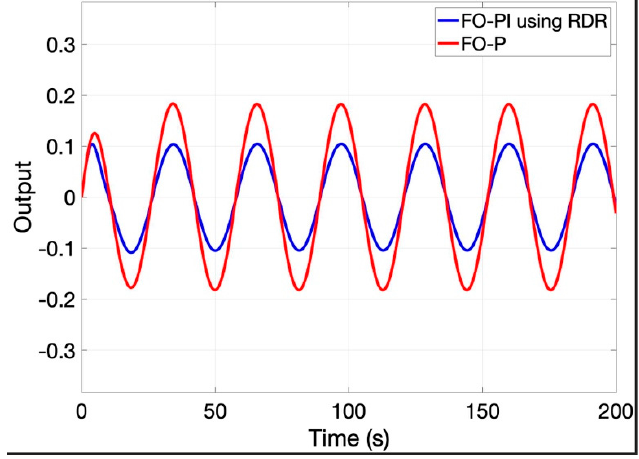
Figure 18. Disturbance rejection results for a higher-order process considering a sinusoidal disturbance signal of frequency ω d (red line—FO-PI designed by Gude 2010).